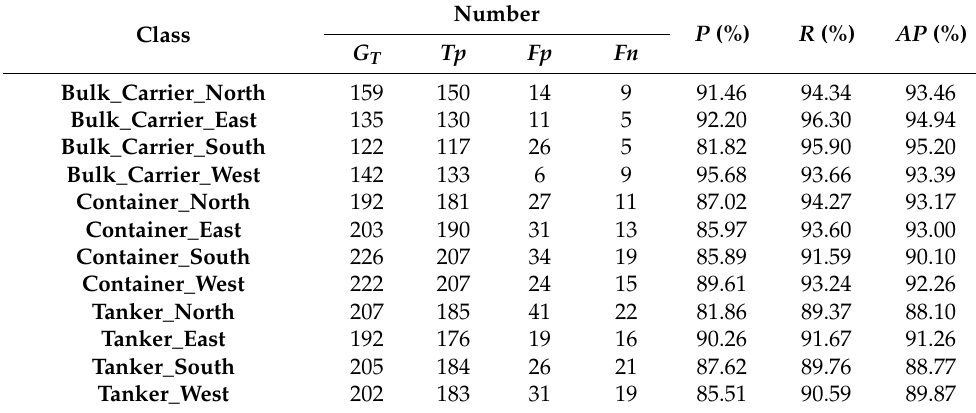
Table 4. The number of cargo ships for test set results and the evaluation of our model.